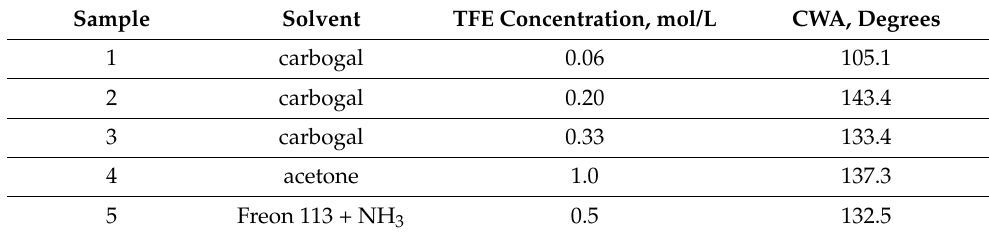
Table 5. Contact water angles for HogC cellulose films after